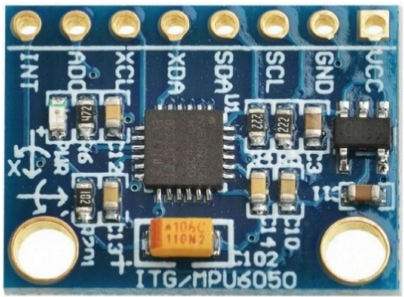
Figure 11. The six DoF IMU, MPU6050 chip consists of a 3-axis ACC and 3-axis gyroscope [50].